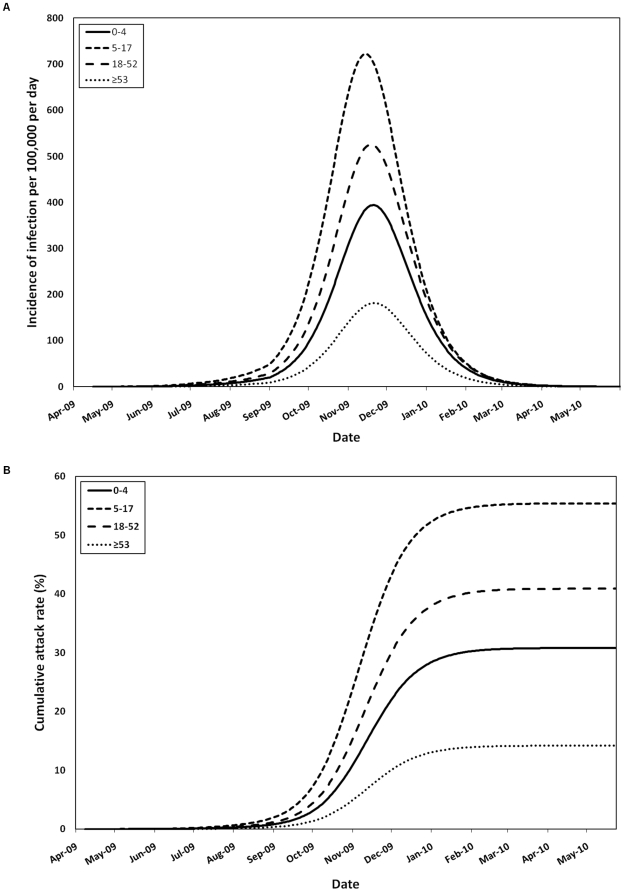
Model-predicted pH1N1 infection dynamics in the absence of vaccination.(A) Simulated age-stratified daily pH1N1 infection incidence per 100,000 population and (B) age-specific attack rates between April 2009 and June 2010, in the absence of vaccination or other interventions. Both symptomatic and asymptomatic cases are shown. The curves are based on an assumption of fifty percent pre-existing immunity in the ≥53 age group and a decrease in Re from 1.3 to 1.15 between July and September.